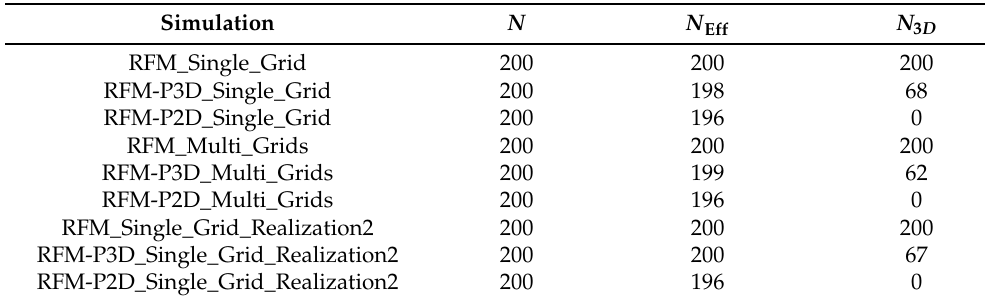
Table 2. Desired mode number N , effective mode number N Eff and three-dimensional structure number N 3 D for the